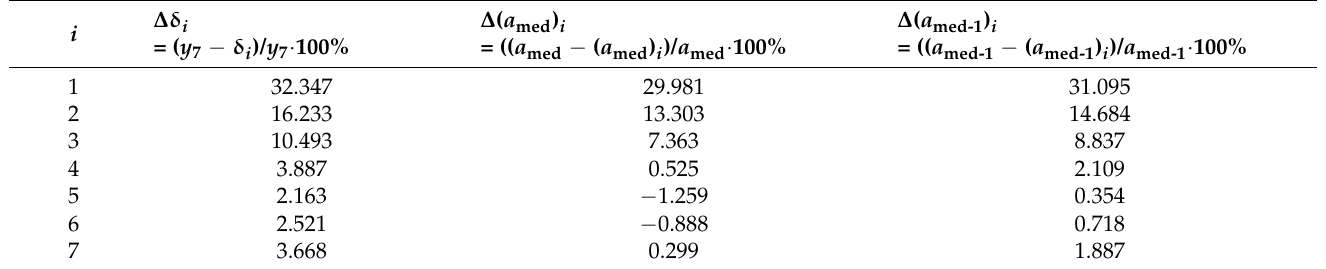
Table 14. Deviations of estimated values δ i , ( a med ) i and ( a med-1 ) i from values δ 7 , a med and a med-1 for PAI 25 press